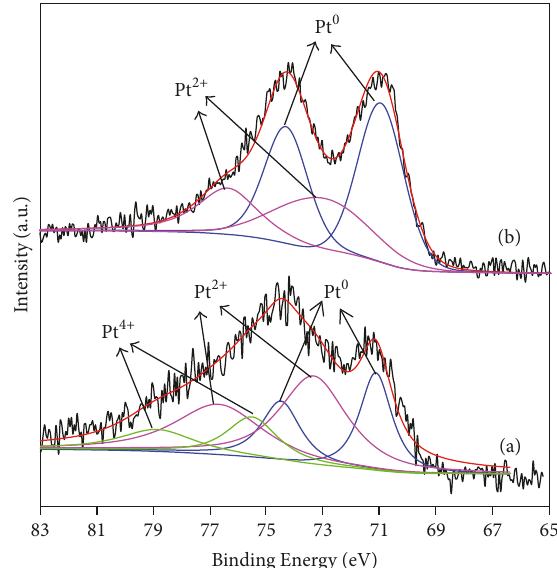
Figure 3: Pt 4f XPS spectra of (a) Pt/SiO 2 and (b) Pt-Cu/SiO 2